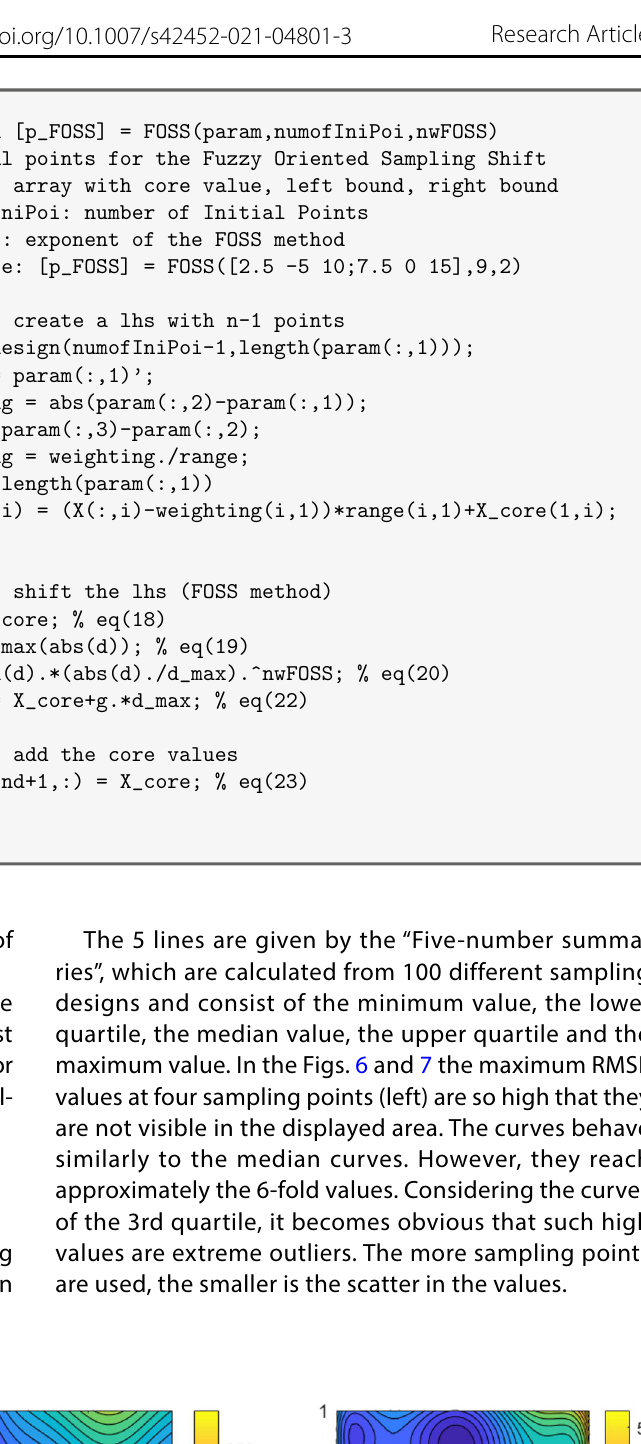
Fig. 5 Branin function(left) and Camelback function(right) in the given limits as testfunc-